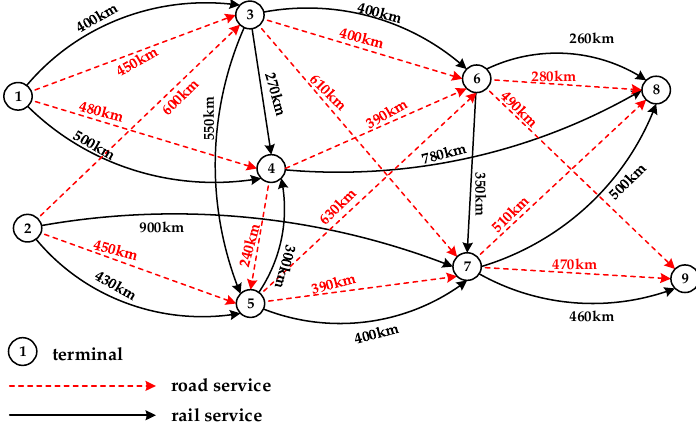
Figure 4. A multimodal service network.